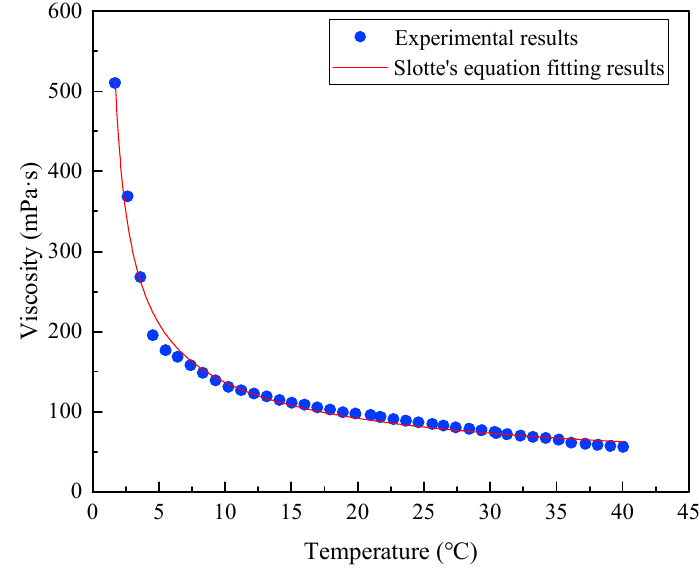
Figure 5. Viscosity–temperature curve of magnetic fluid.